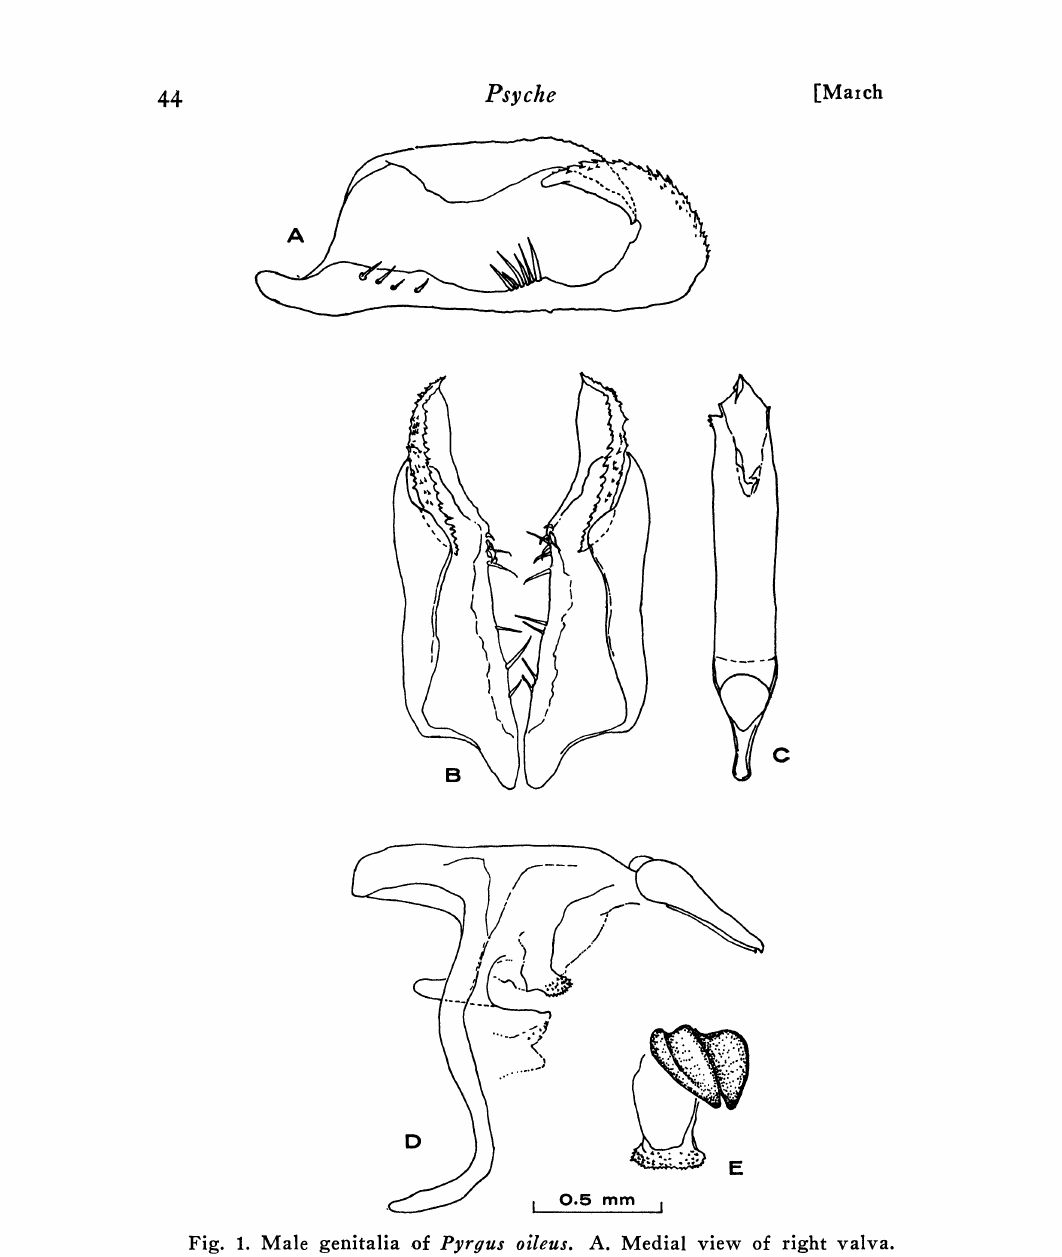
Fig. 1. Male genitalia .of Pyrtlus oileus. A. Medial view of right valva. B. Dorsal view of both valvae. C. Dorsal view of aedeagus. D. Left lateral view of uneus, tegumen, gnathos, vineulum, and saeeus. E. Left dorsolateral view of uneus and gnathos. [A, drawn from one male, and B to E, from another; both from Houston, Harris County, Texas, VIII-12- 1957 (J. M. and S. N.